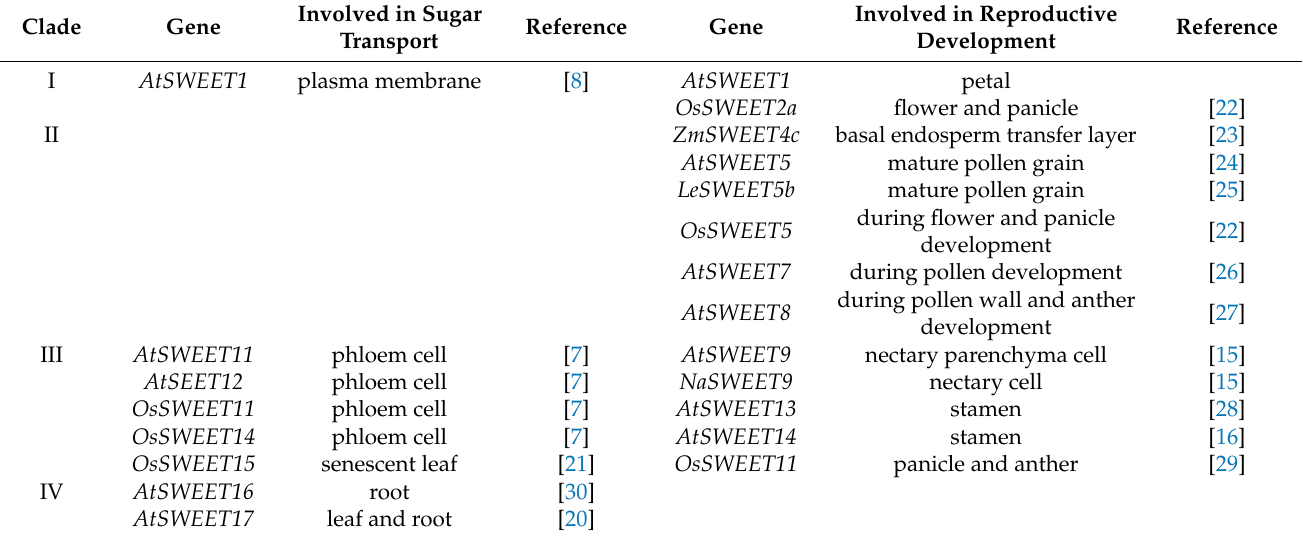
Table 1. SWEET genes involved in physiological